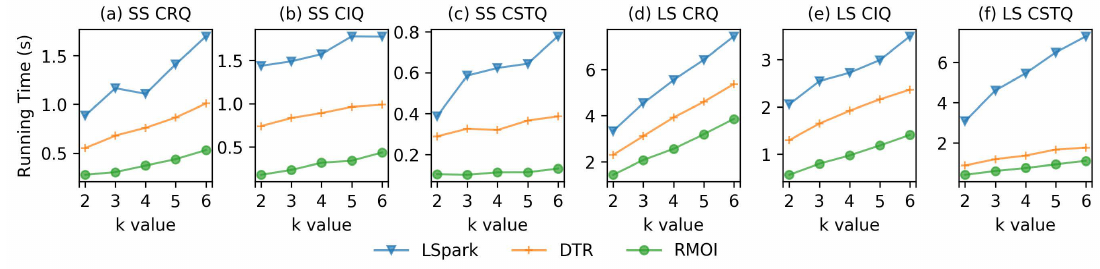
Figure 6. Average execution time for the SF dataset with low resource availability on ( a ) continuous range query with small selectivity, ( b ) continuous interval query with small selectivity, ( c ) continuous spatio-temporal query with small selectivity, ( d ) continuous range query with large selectivity, ( e ) continuous interval query with large selectivity, and ( f ) continuous spatio-temporal query with large